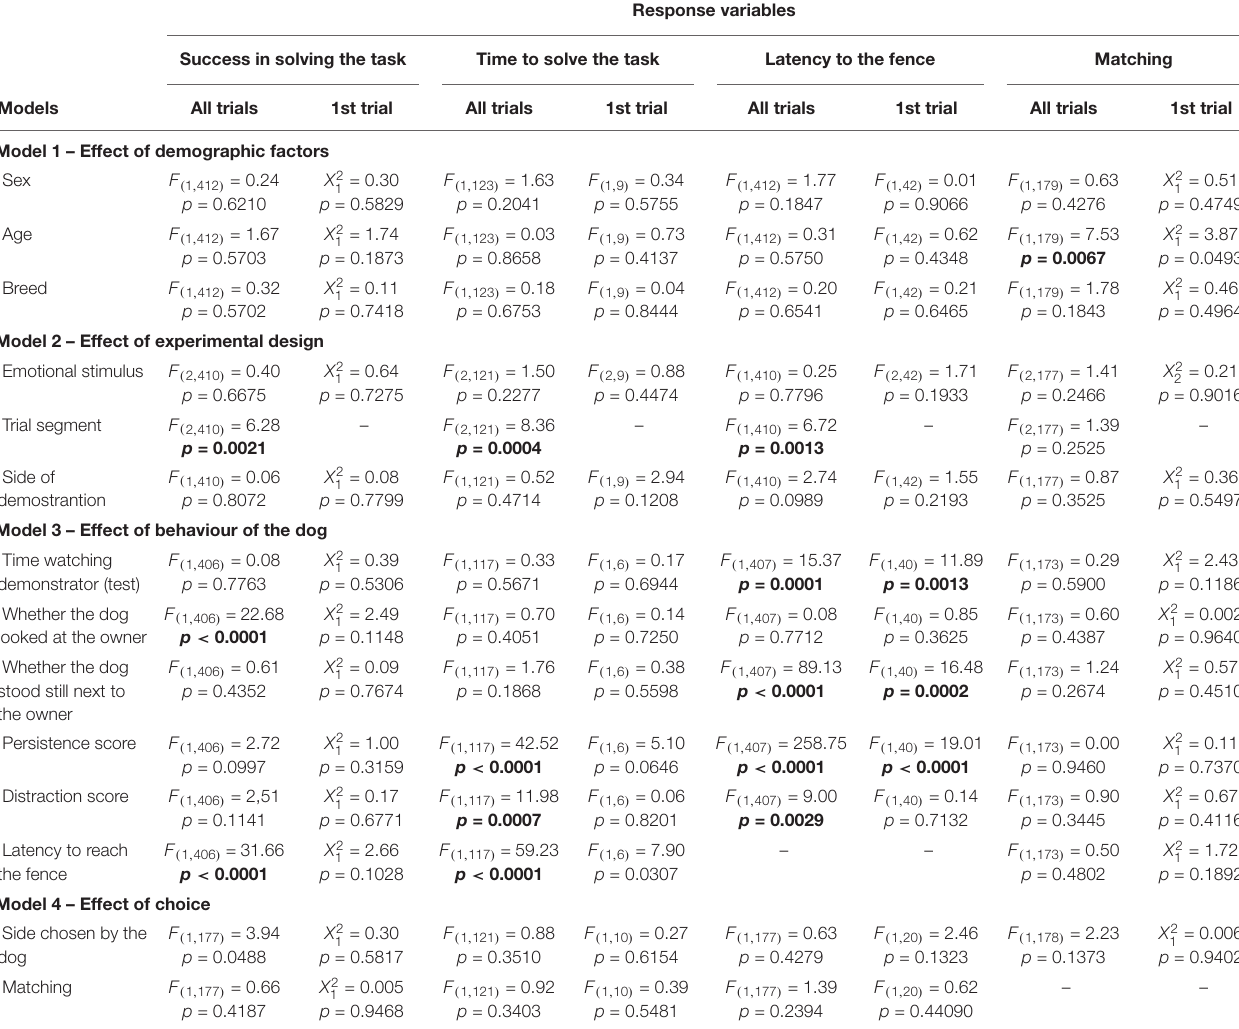
TABLE 2 | Summary of the results of the models (statistic and p